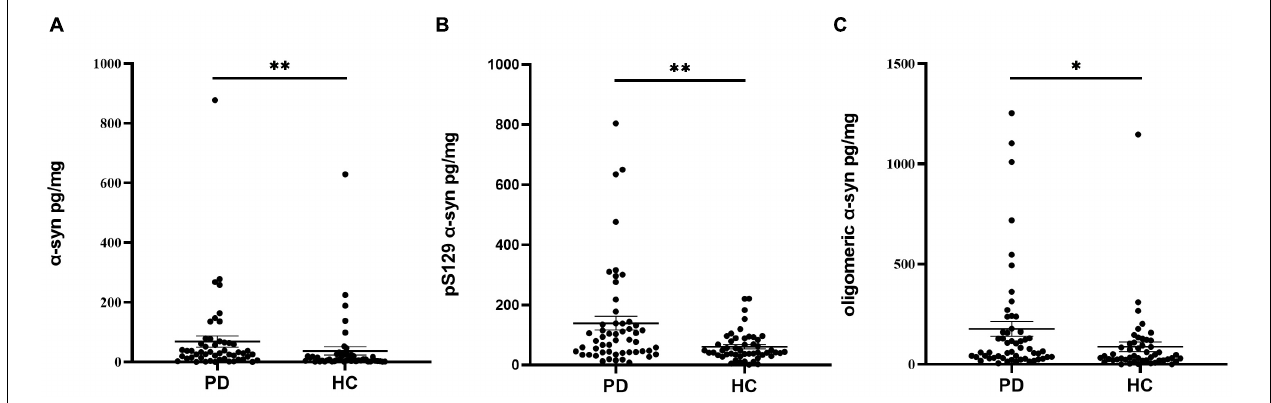
FIGURE 3 | The concentrations of α -Syn, pS129, and oligomeric α -Syn in oral mucosa samples of PD patients and controls. (A) α -Syn, normalized to total oral mucosa cells proteins (pg/mg); ∗∗ p = 0.001 (Mann Whitney U test); (B) pS129, normalized to total oral mucosa cells proteins (pg/mg); ∗∗ p = 0.002 (Mann Whitney U test); (C) oligomeric α -Syn, normalized to total oral mucosa cells proteins (pg/mg); ∗ p = 0.013 (Mann Whitney U